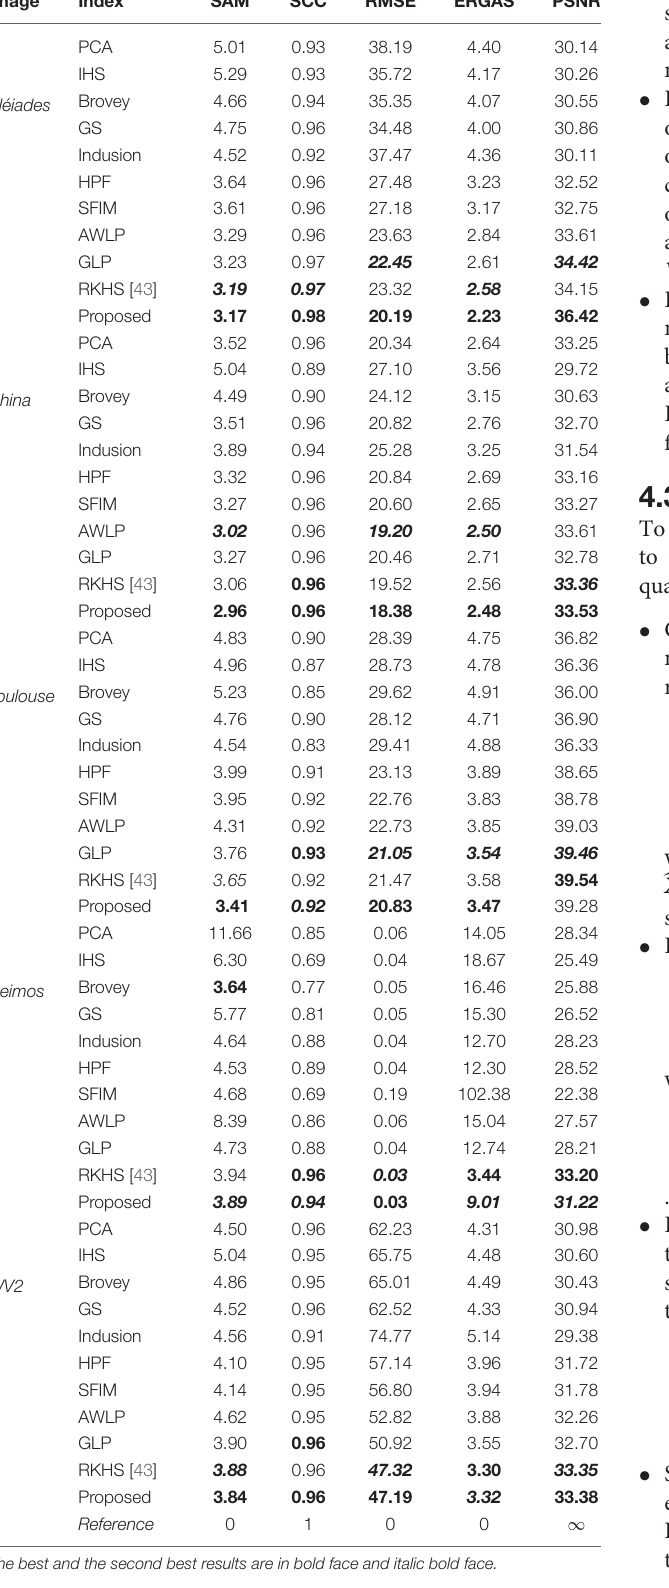
TABLE 2 | Quantitative Results with for pansharpening ω = 4.